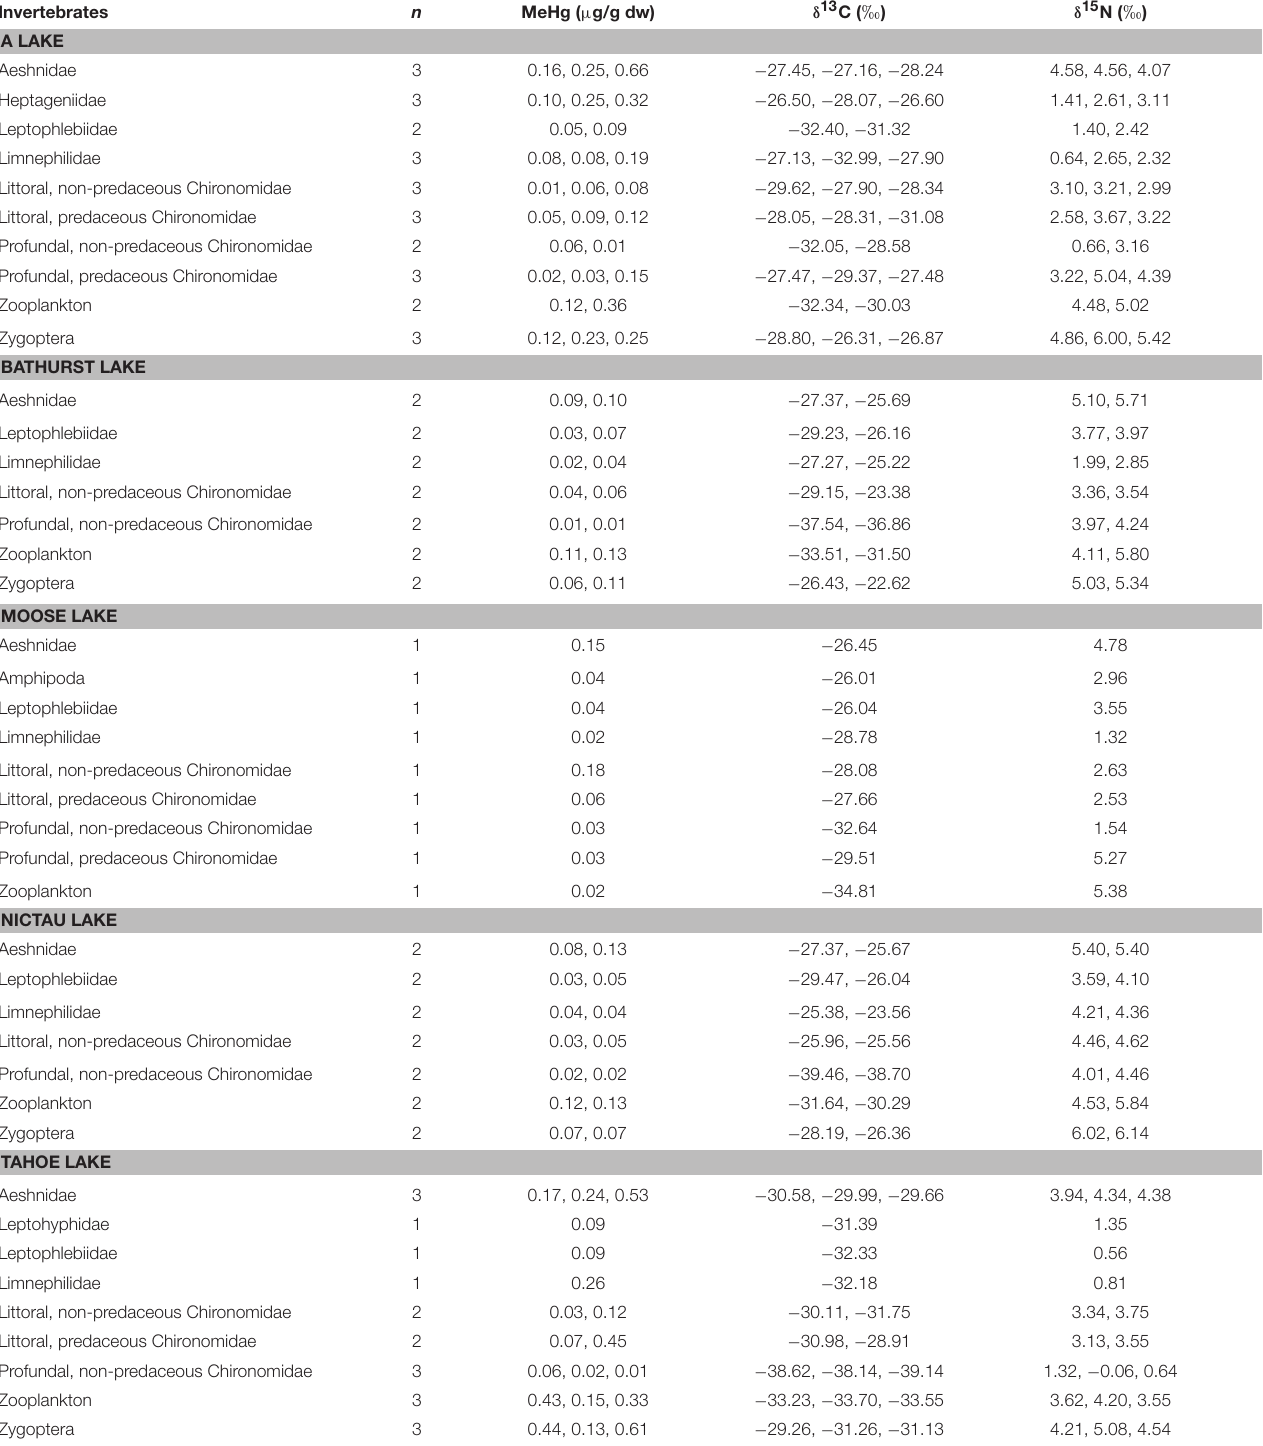
TABLE 3 | MeHg ( µ g/g dw), δ 13 C ( h ), and δ 15 N ( h ) of invertebrates collected in A, Bathurst, Moose, Nictau, and Tahoe lakes, New Brunswick, Canada.